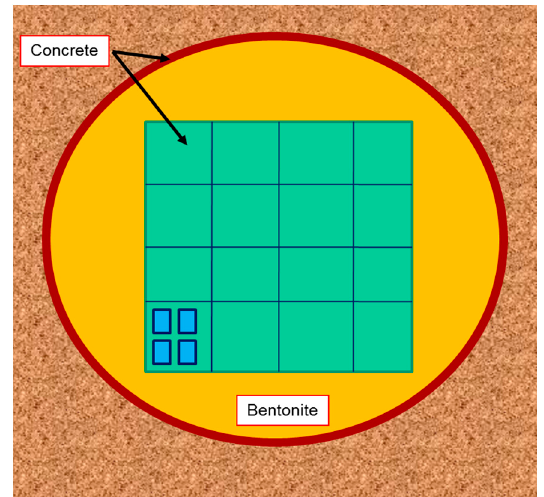
Figure 1. An example waste cavern design for a cementitious L / ILW (low- and intermediate-level waste) repository. Waste containers ( blue , typically 200 L metal drums filled with waste and a cement grout) are encased in concrete boxes ( green ) which are usually backfilled with more cement grout. The boxes are then protected by industrial bentonite to minimise groundwater interaction with the waste. The tunnel walls may also be supported by concrete tunnel liners. From [9].